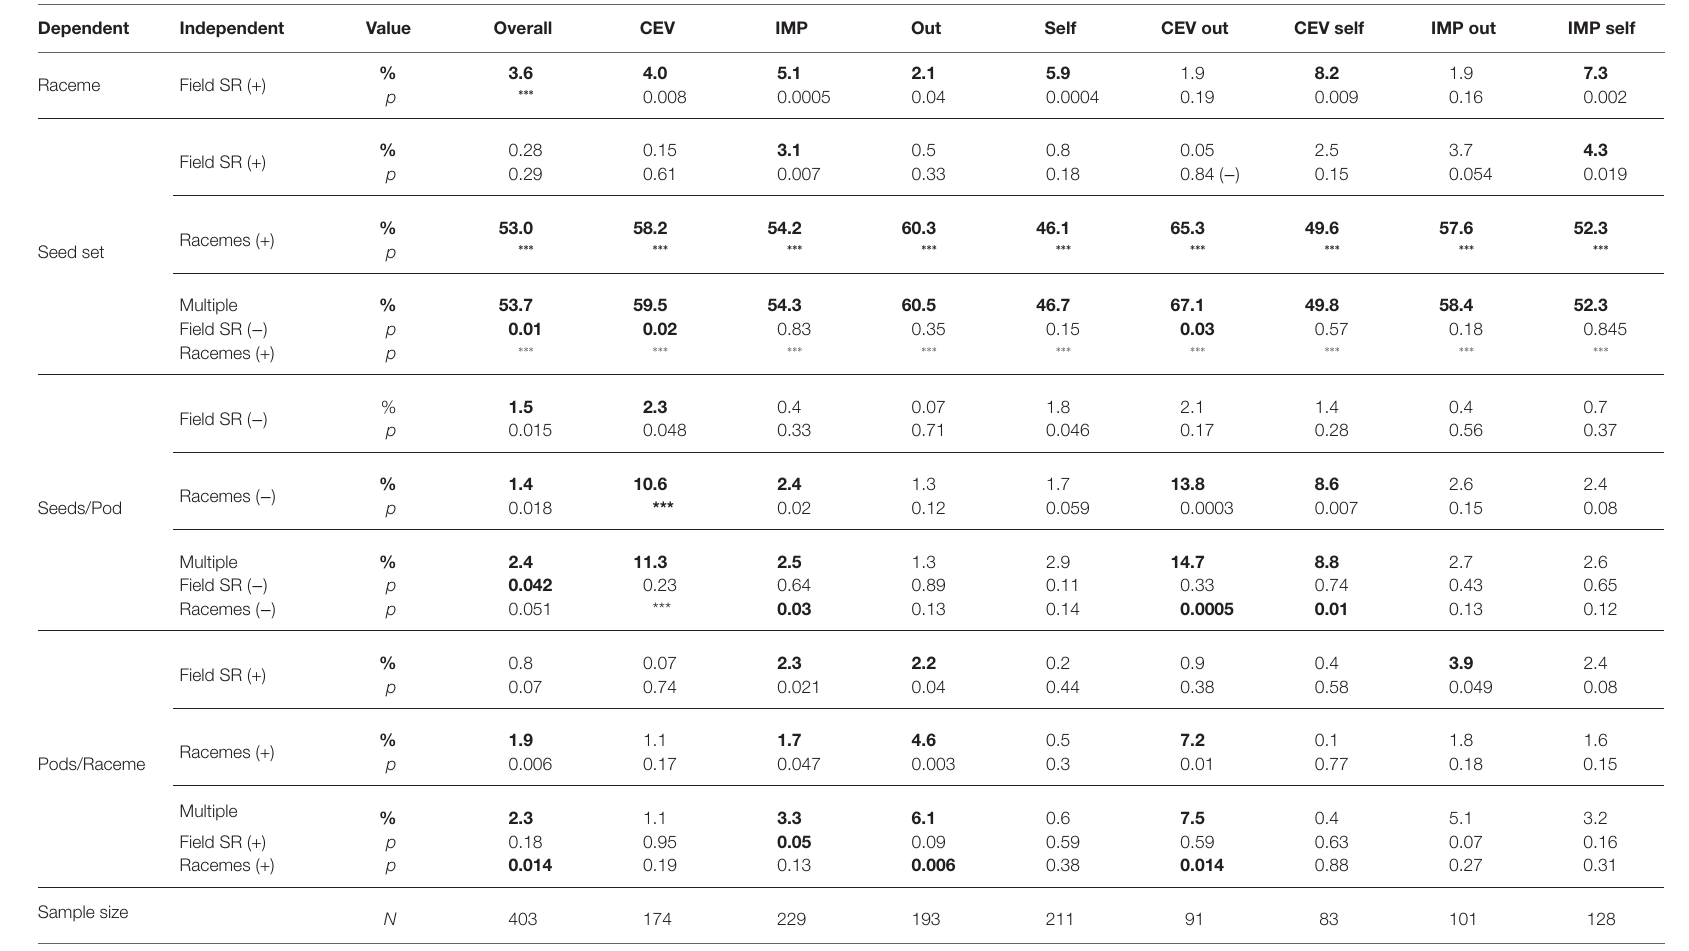
TABLE 5 | Field selfing rate, number of racemes, and seed yield metrics. Dependent Independent Raceme